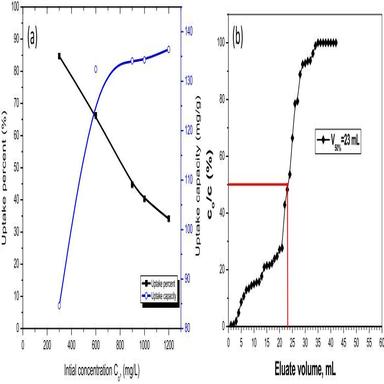
Static and dynamic sorption capacity (a) Uptake percentage (%) and capacity (mg/g) of Mo(VI) as a function of initial concentration of Mo(VI) (b) Breakthrough curve of 99Mo(VI) from 50 mg mesoporous (MnO2/MWCNT) column using 250 mg/L99Mo(VI) feeding solution at inside diameter (0.4 cm i.d.) with flow rate 0.25 mL/min.